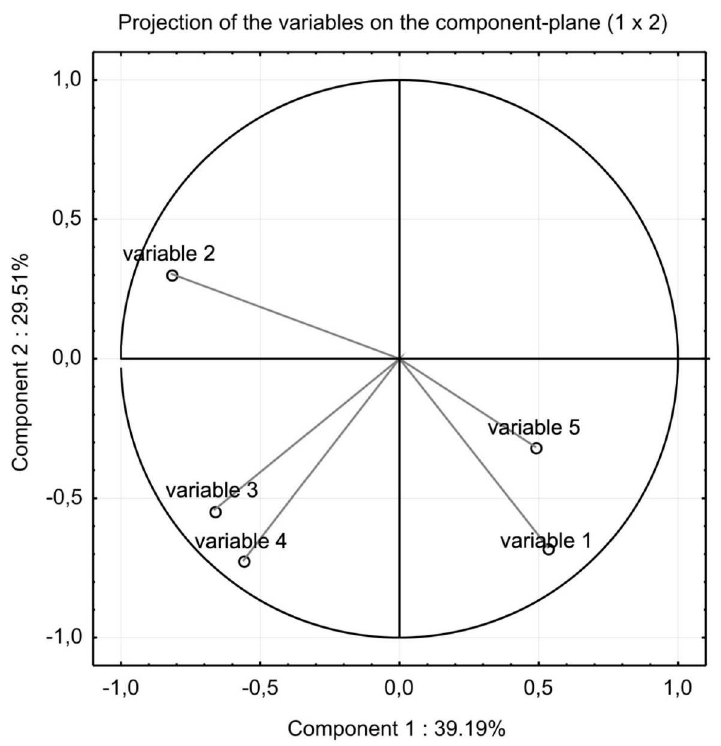
Figure 1. The representation of the components’ coordinates in the space defined by the selected